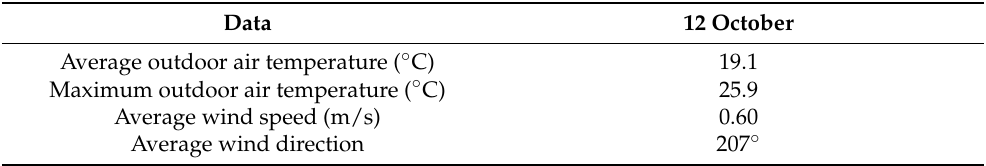
Table 6. Ambient conditions on 12